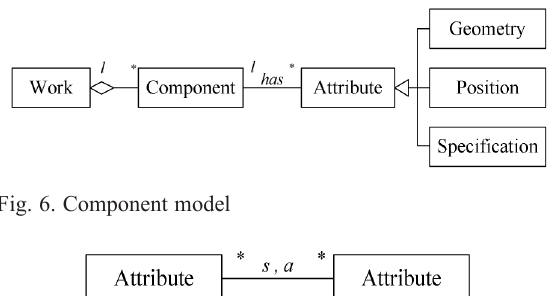
Fig. 7. Change propagation